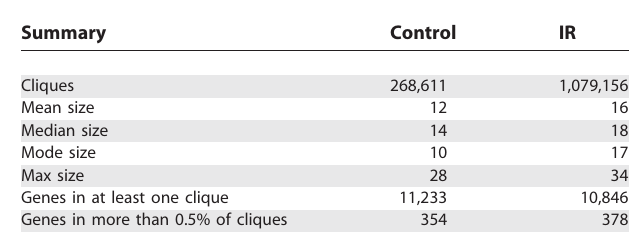
Table 1. Summary of Edges Included in the Graphs